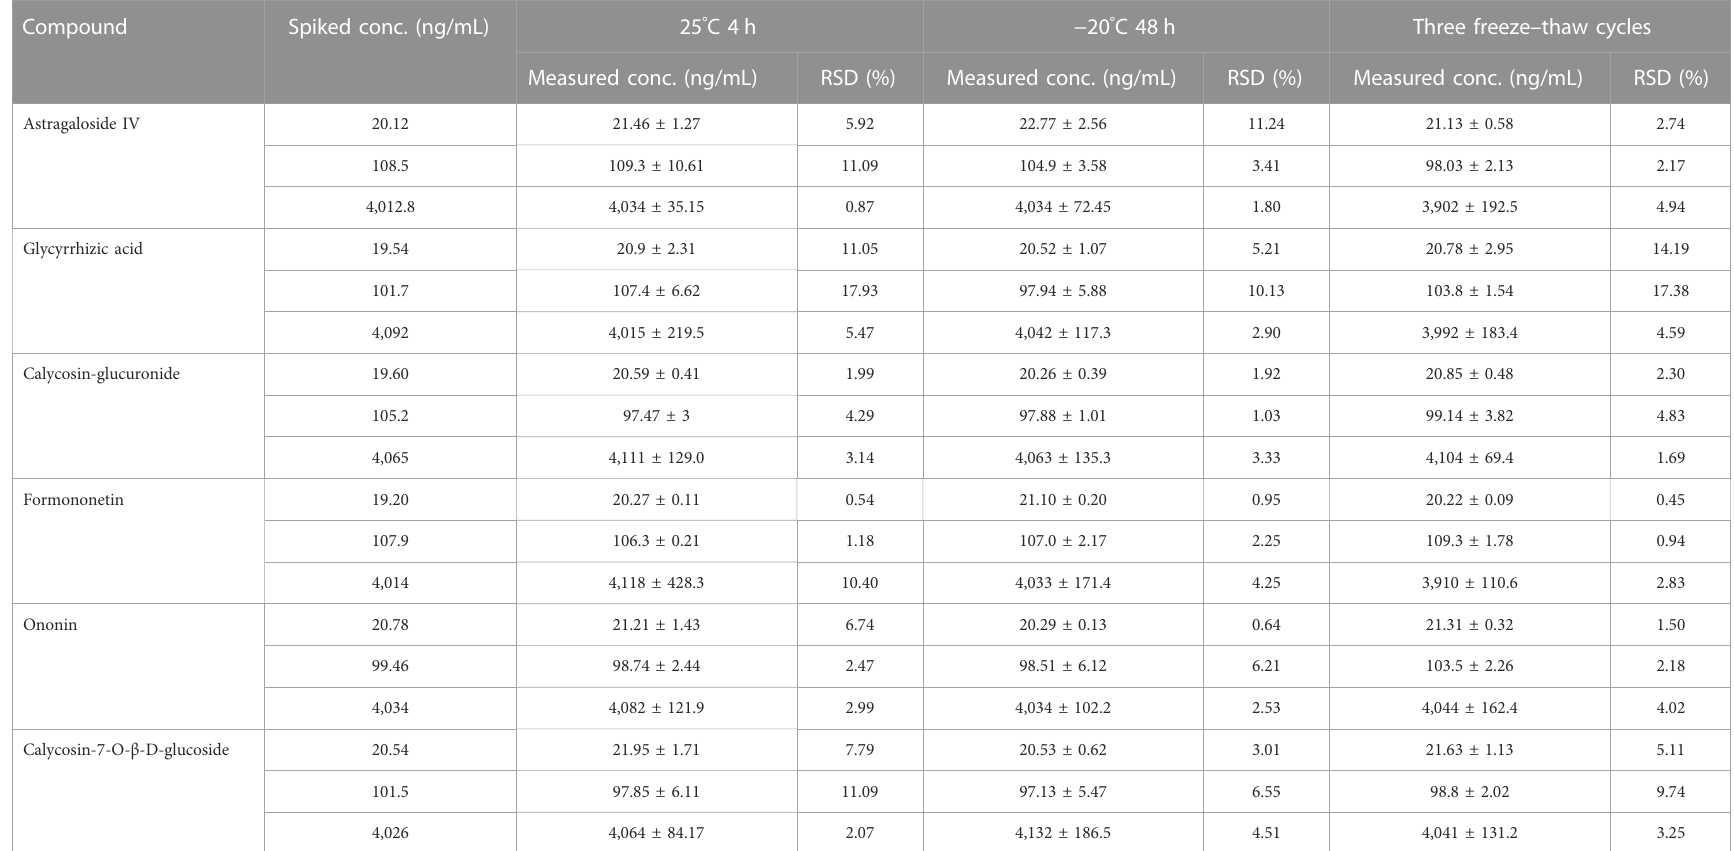
TABLE 6 Stability of the six components in liver microsomal samples. (x ± SD, n = 6).